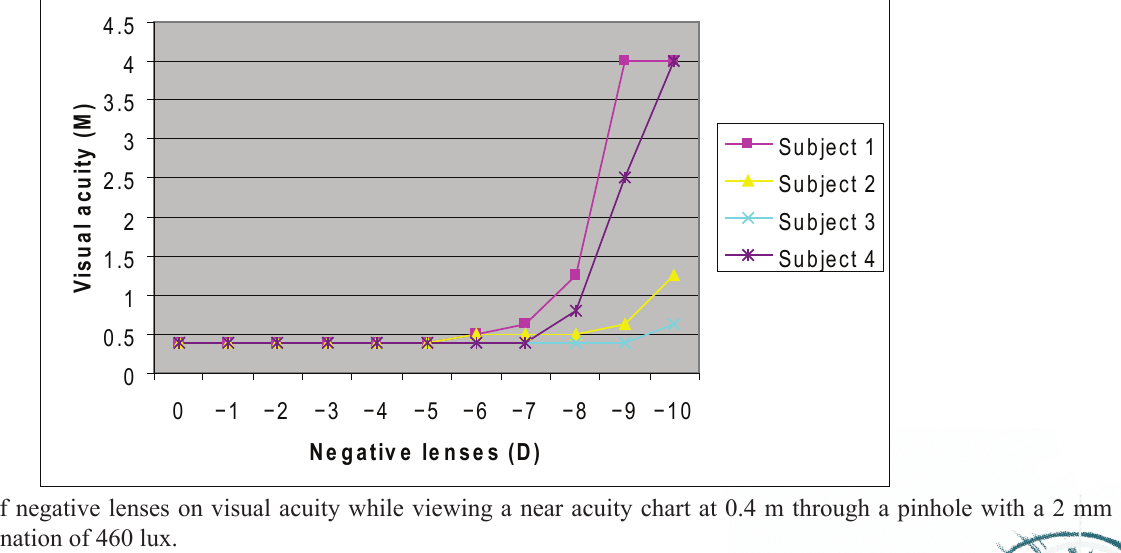
The South African Optometrist